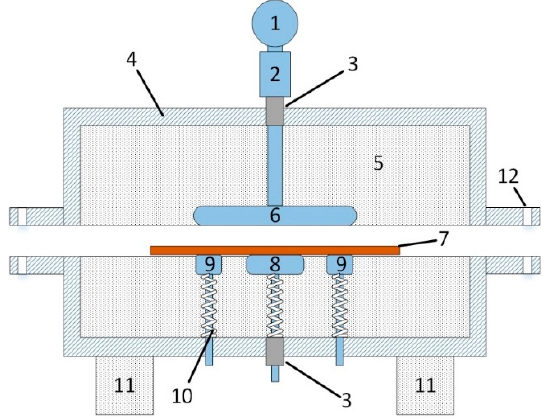
Figure 2. Schematic diagram of the conductivity measurement circuit.